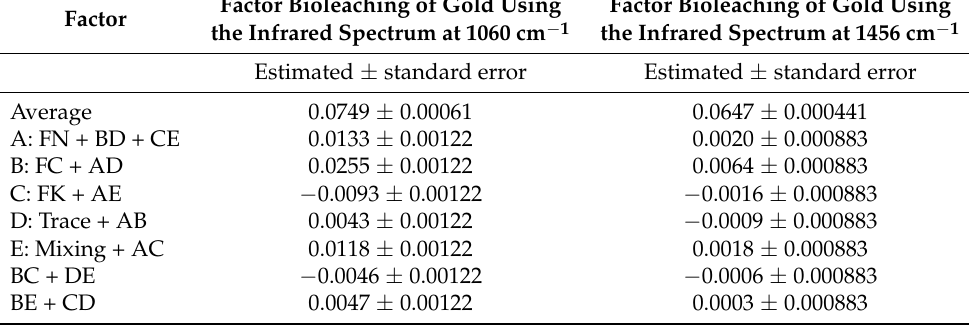
Table 3. Estimated Effects for the 2 5 − 2 Fractional